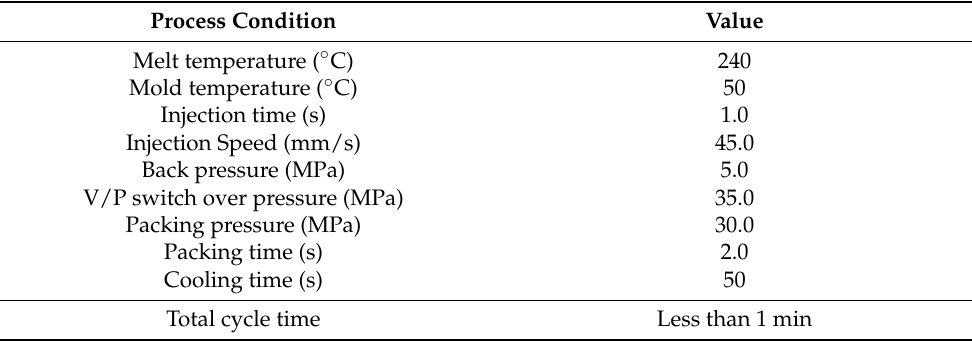
Table 4. Injection molding conditions for the mesh-inserted